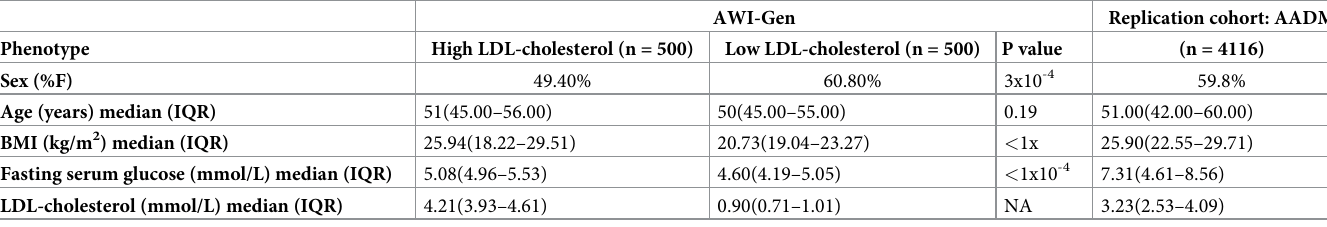
Table 1. Phenotype characterisation of 1000 AWI-Gen participants and 4116 AADM